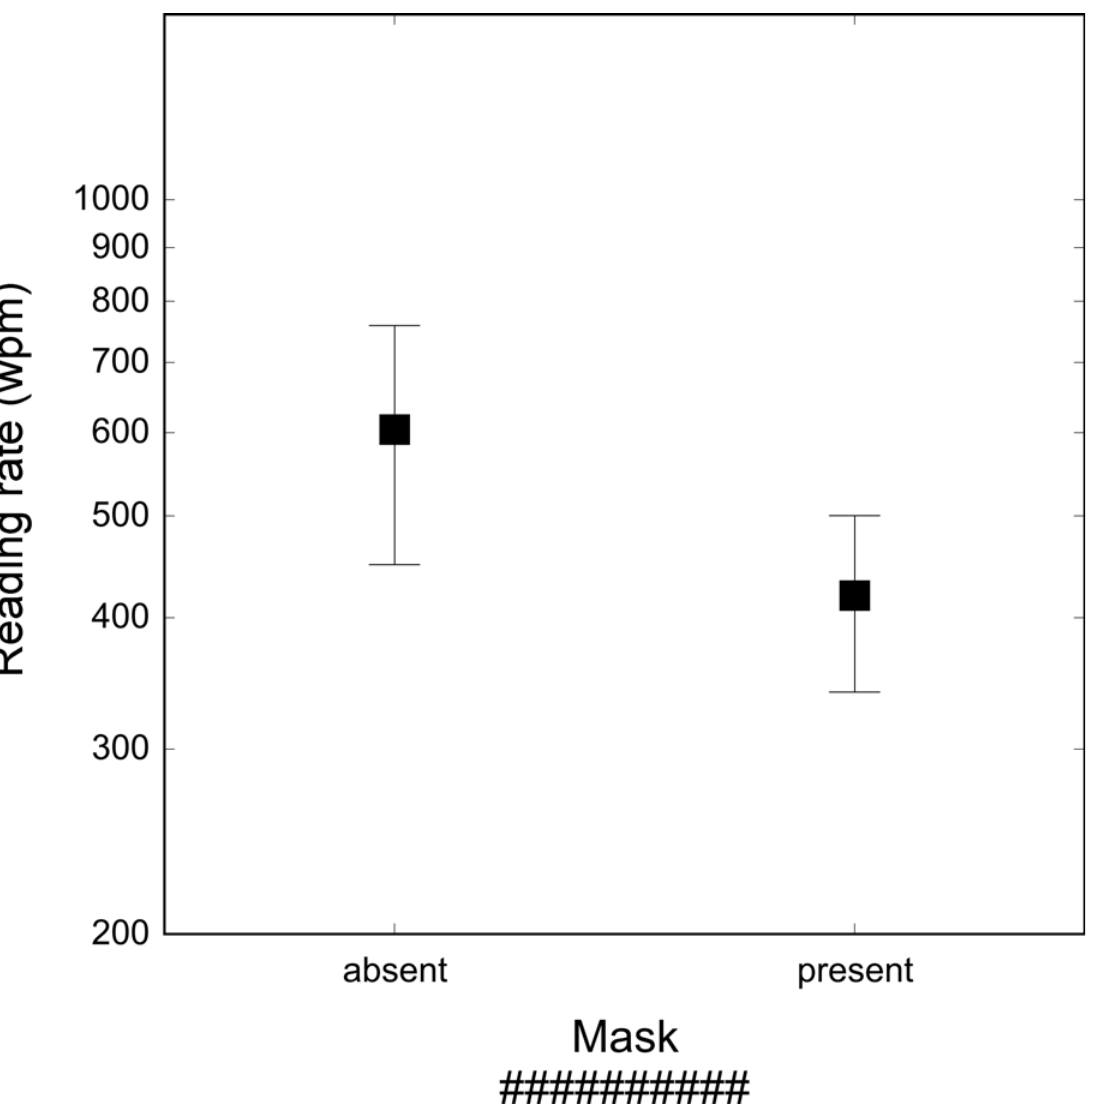
Fig 1. Reading rate (wpm) in the absence (left) and in the presence (right) of a mask. The features of the mask are shown above. Bars represent standard